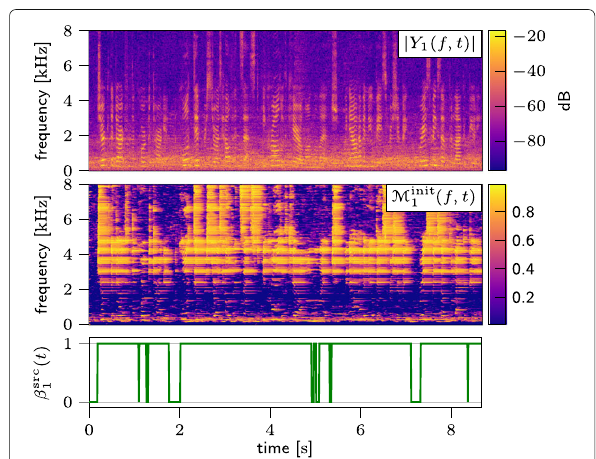
Fig. 4 Extraction of source time annotations (STAs) β src j ( t ) for J = 1 static source from the corresponding initial mask ( P = 10). The mask only captures the rough outline of the target speech, but this is sufficient to detect silent